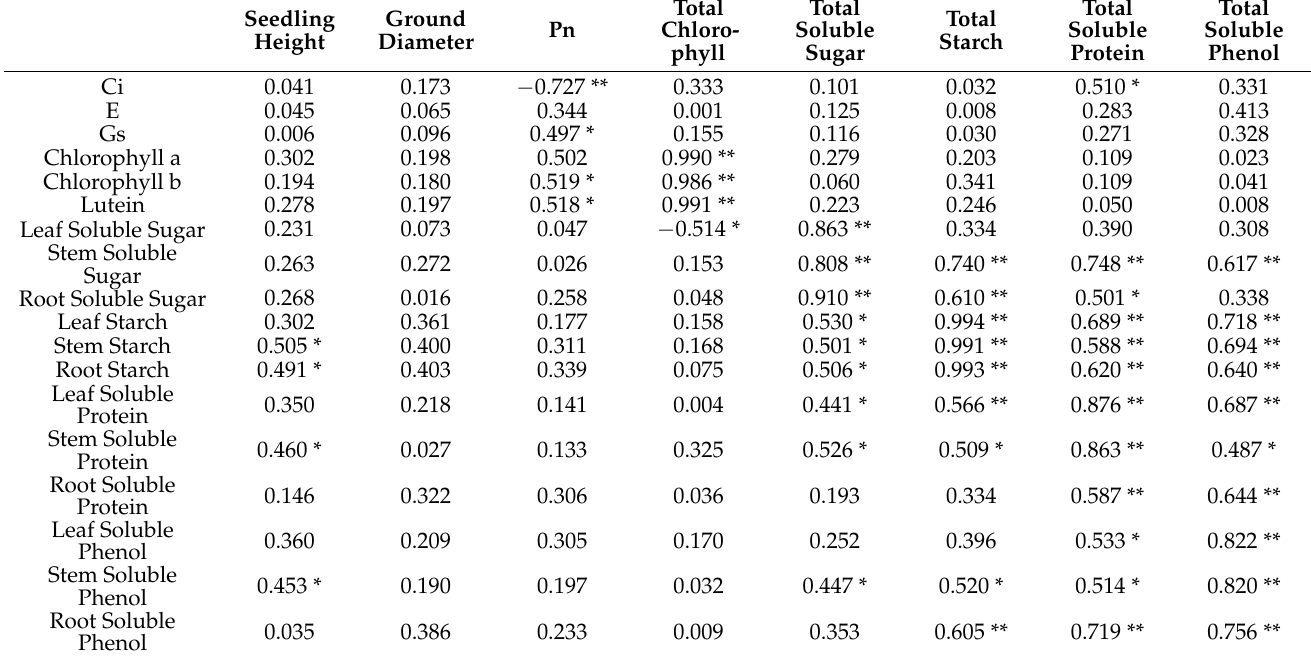
Table 3. Correlation analysis of growth physiological indexes of pecan. * p < 0.05; ** p < 0.01.